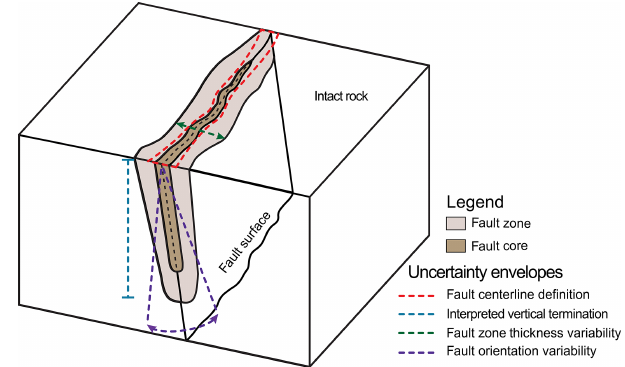
Figure 2. A schematic showing expected uncertainty envelopes due to the specified sources of uncertainty regarding characterizing the 3D geometry of a fault zone in the subsurface. Modified from Kra- jnovich et al.